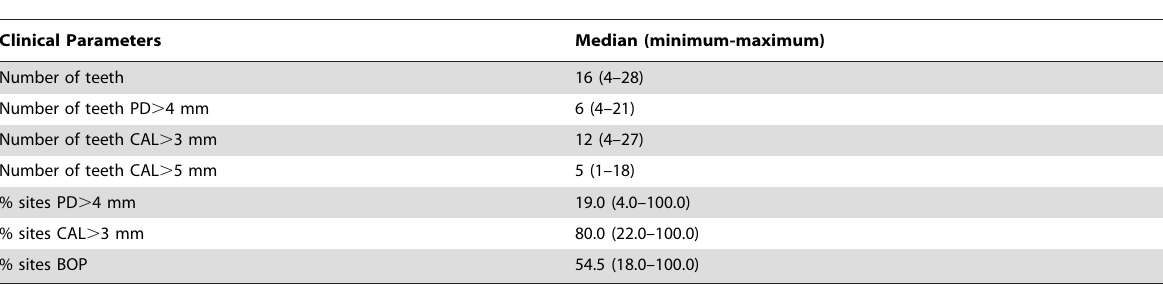
Table 1. Periodontal clinical parameters of samples (n= 24).